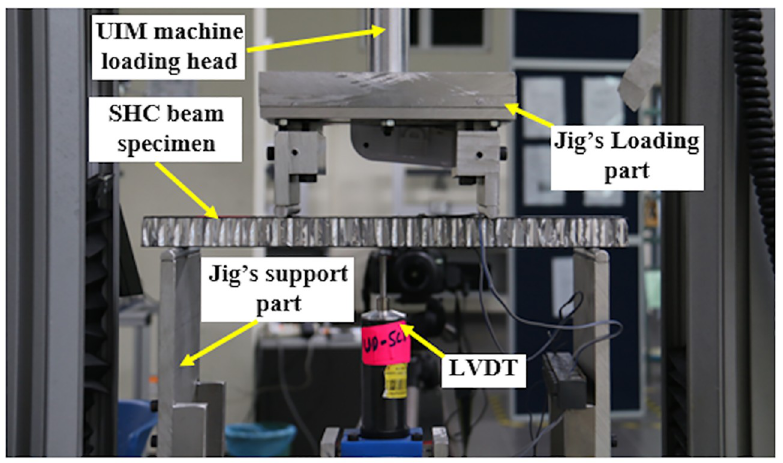
Fig 4. Actual test set-up for SHC beam